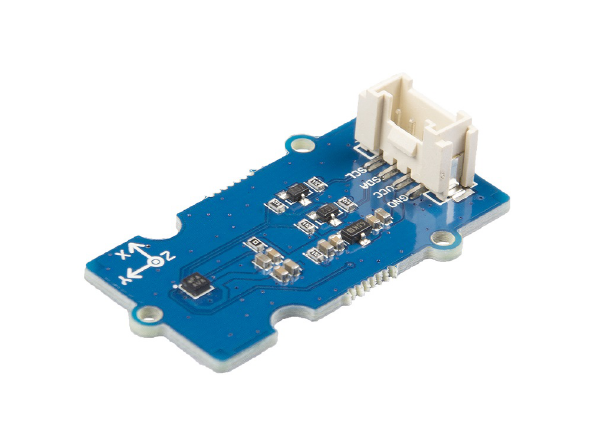
Figure 5. Grove 3 Axis Digital Accelerometer ±16g Ultra-low Power BMA400